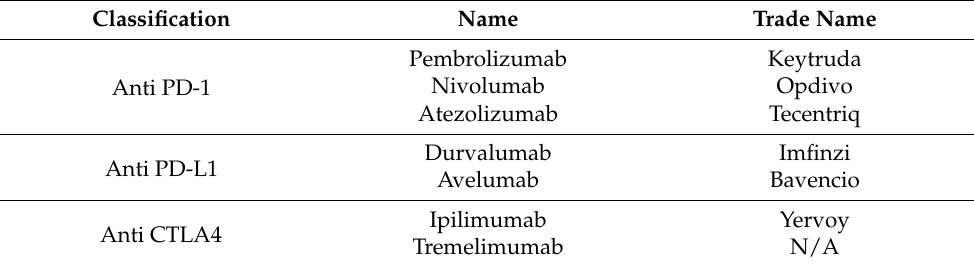
Table 1. Types of immune checkpoint inhibitors.